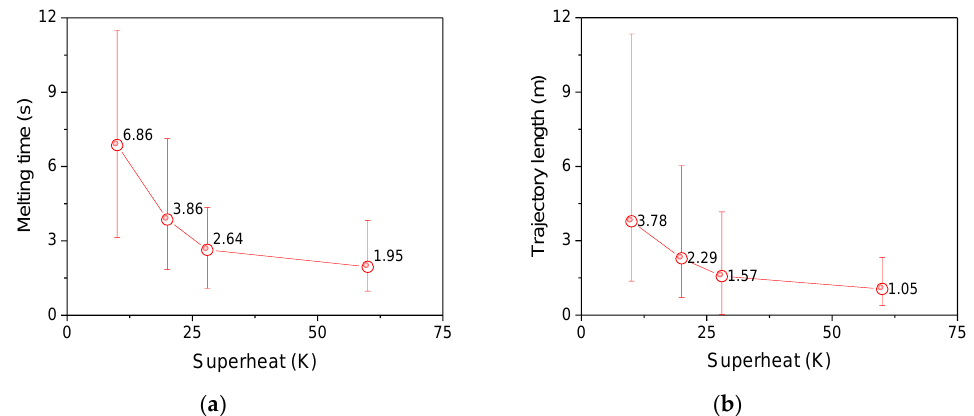
Figure 10. Effect of superheat on the melting time and the trajectory length of aluminum particles: ( a ) Melting time; ( b ) trajectory length.